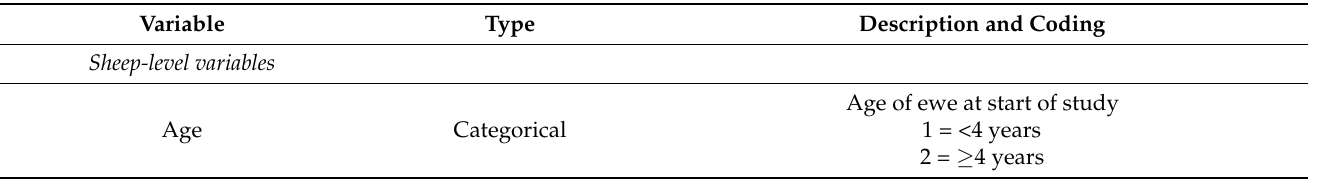
Table 4. Description of variables considered when investigating associations with transitions in states of white line disease at